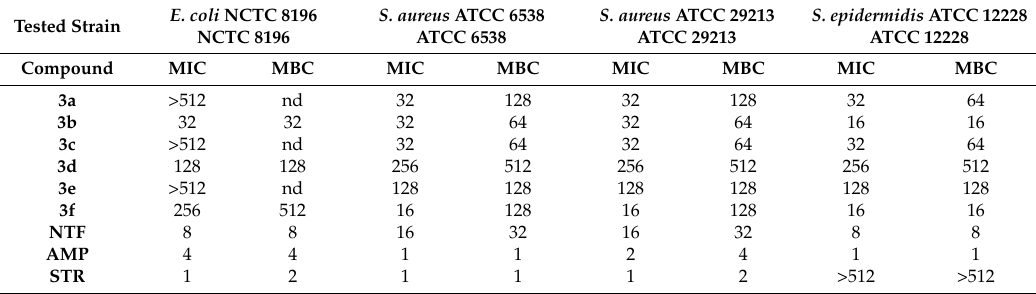
Table 3. In vitro antibacterial activity of 3a , 3b , 3c , 3d , 3e , 3f expressed as a minimal inhibitory concentration (MIC) ( µ g/mL) and a minimal bactericidal concentration (MBC) ( µ g/mL). AMP: ampicillin, NTF: nitrofurantoin, STR: streptomycin. Tested Strain